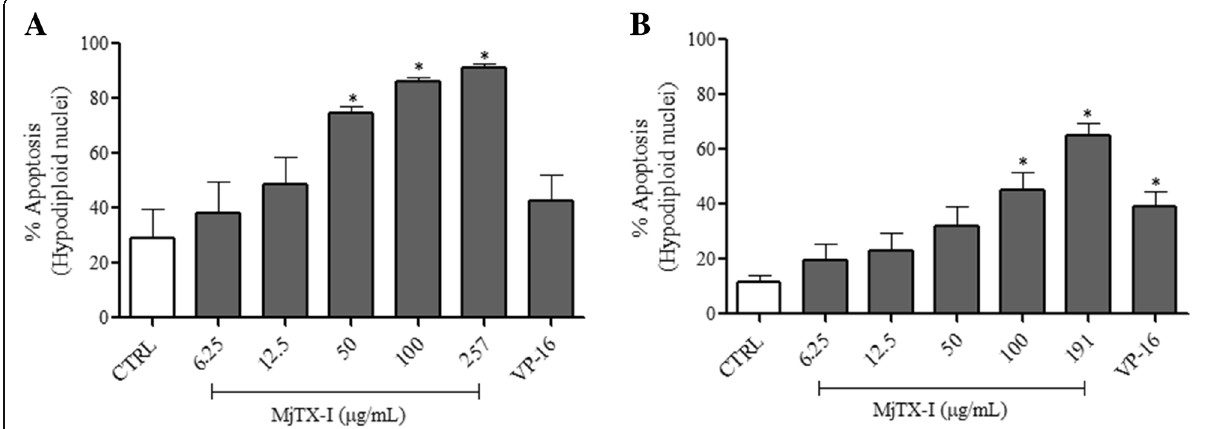
Fig. 3 Quantification of MjTX-I-induced apoptosis in ( a ) K562-S and ( b ) K562-R cells, assessed by the hypotonic fluorescent solution (HFS) method. Results are expressed as mean percentage of cells with hypodiploid nuclei ± standard deviation of three independent experiments. CTRL: untreated cells (negative control). VP-16: etoposide (positive control). * p <0.05 vs. CTRL (One-way ANOVA followed by the Tukey ’ s post-hoc